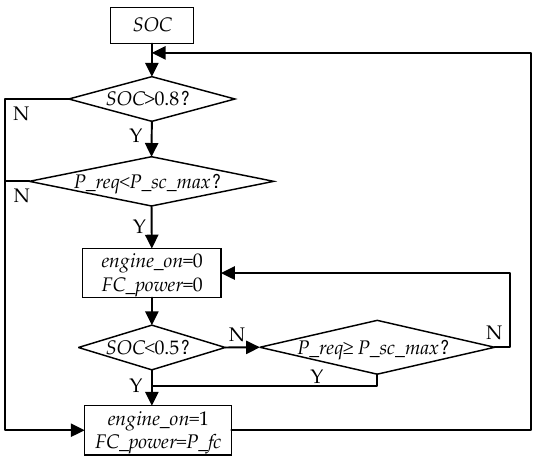
Figure 5. Switch control rules.